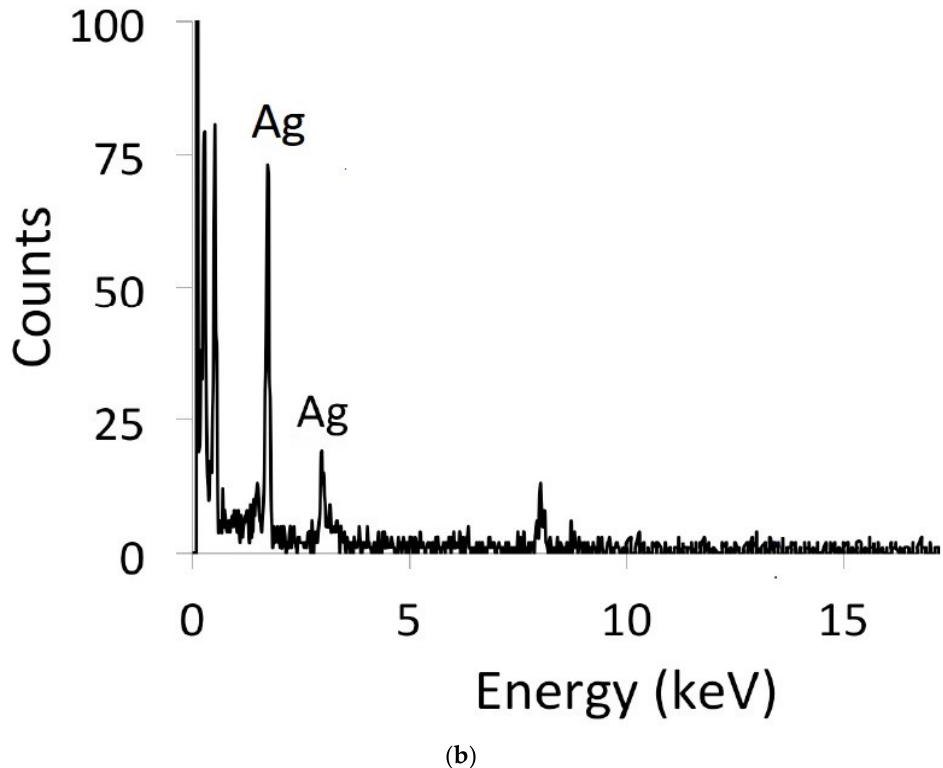
Figure 1. Characterization of Ag ceramic: ( a ) ceramic cubes; transmission electron microscopy (TEM) images of the silver patches in a ceramic cube; ( b ) X-ray energy dispersive (EDX) spectrum of Ag.